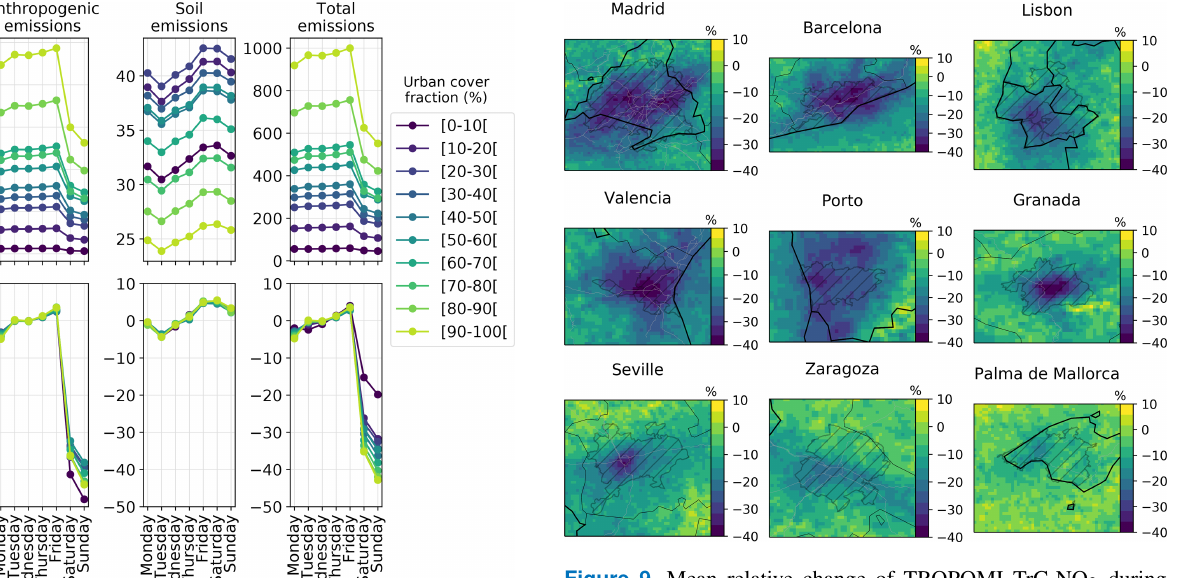
Figure 9. Mean relative change of TROPOMI TrC-NO 2 during the weekend relative to the week over the main Iberian Peninsula cities. Black lines, grey lines and hatched areas correspond to ad- ministrative borders, Spanish major roads and functional urban ar- eas, respectively (sources: see Sect. 2.4). Pixels are shown at their 0 . 025 ◦ × 0 . 025 ◦